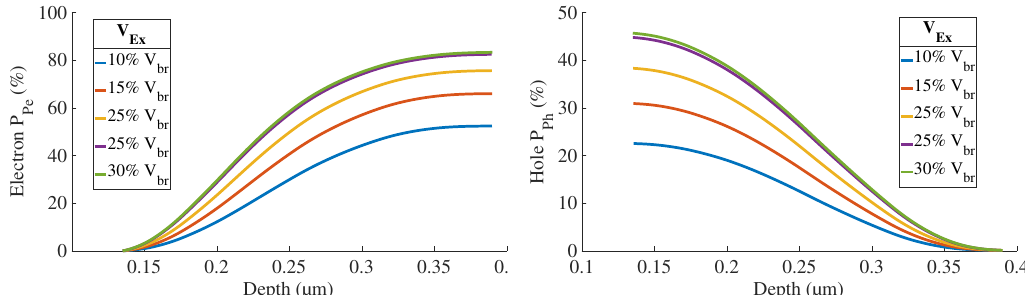
Figure 7. P pe ( z ) and P ph ( z ) are respectively the probability for an electron/a hole starting from the position z inside the depletion region to trigger an avalanche.